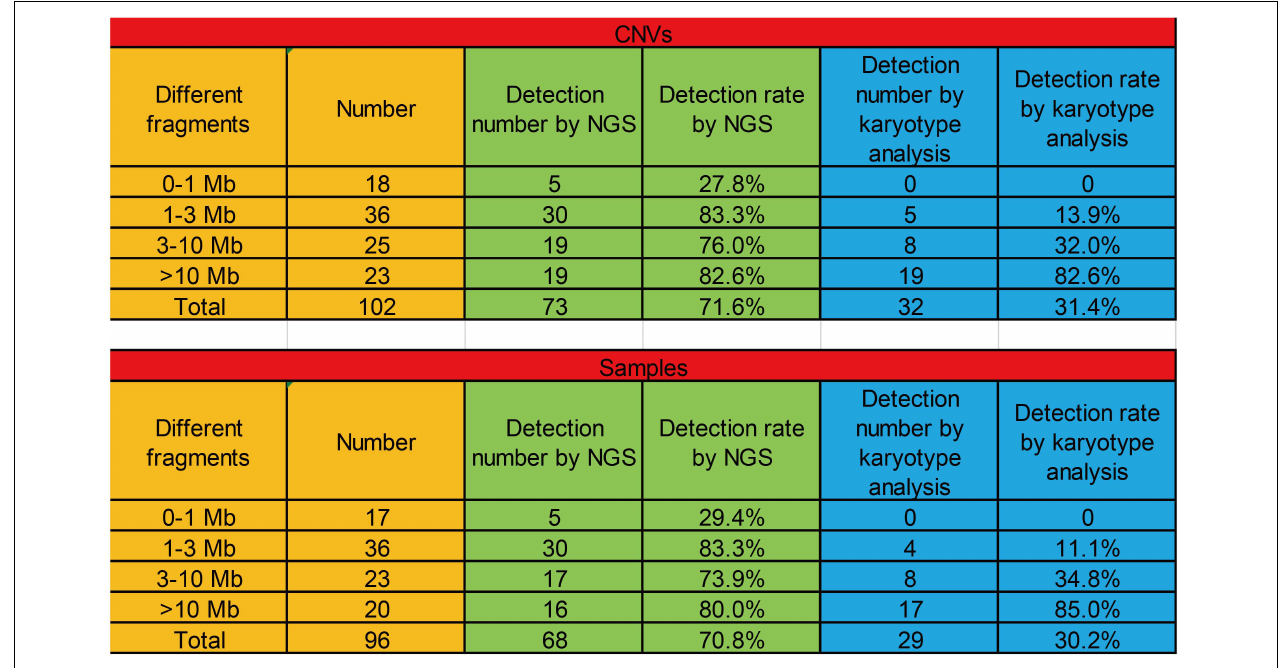
FIGURE 6 | The positive detection rates of CNVs with different fragments (0–1, 1–3, 3–10, and > 10 Mb) among CMA, NGS, and karyotype